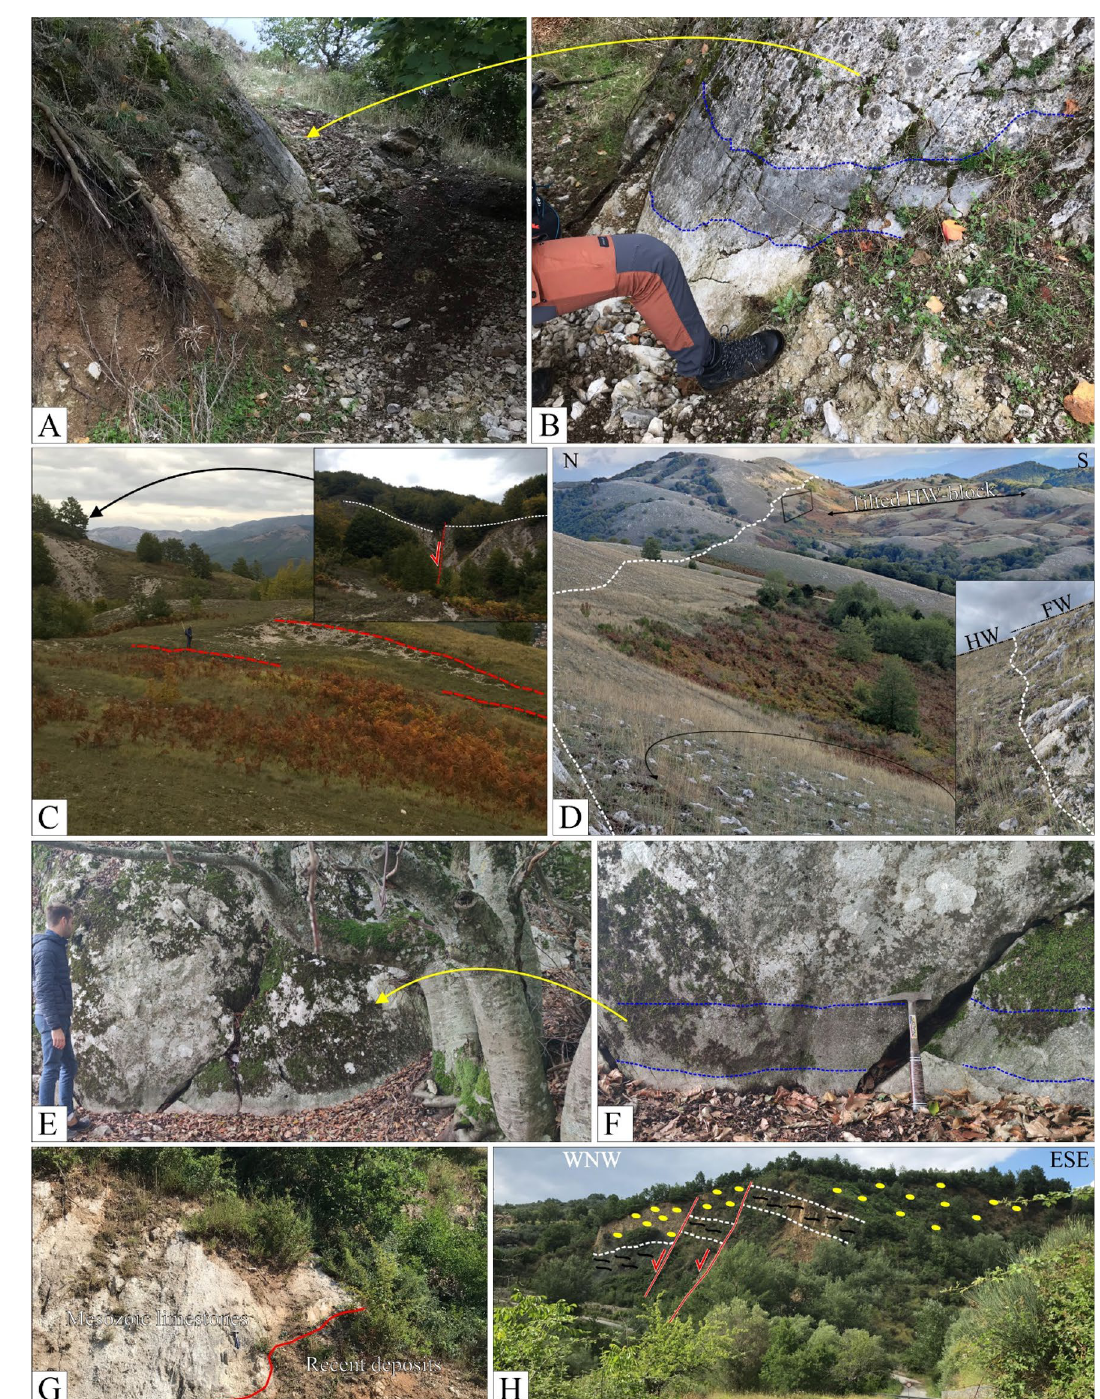
Figure 5. Evidence of Quaternary activity. (A) and (B) Weathered ribbons on limestone slickensides at the southern tip of the Timpe fault section. (C) Fault scarps in continuity at the southern tip of the Polla section. (D) Fault-controlled elongated basin in one of the topographically highest sectors of the Monti della Maddalena ridge, in the central portion of the Atena-Paterno section. (E) and (F) Weathered ribbons on limestone slickensides in the central portion of the Marsicovetere section. (G) Displaced recent deposits along the Marsicovetere section. (H) Displaced continental Quaternary fms along the Montemurro